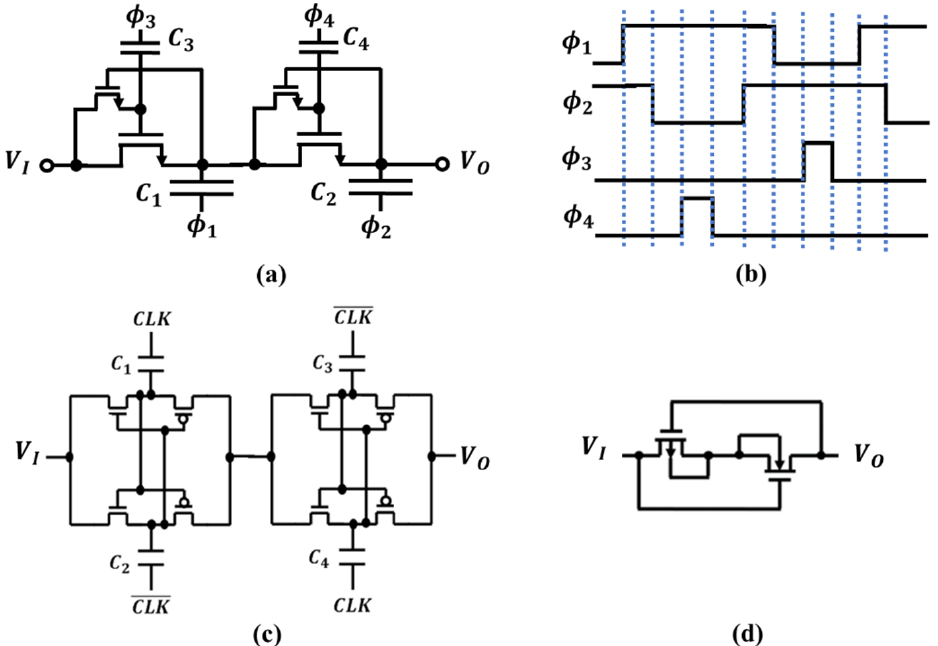
Figure 2. Charge transfer switches (CTSs) with local gate boosters ( a ), four-phase clock ( b ), CMOS latch or cross-coupled CSTs ( c ), and ULPD ( d ).